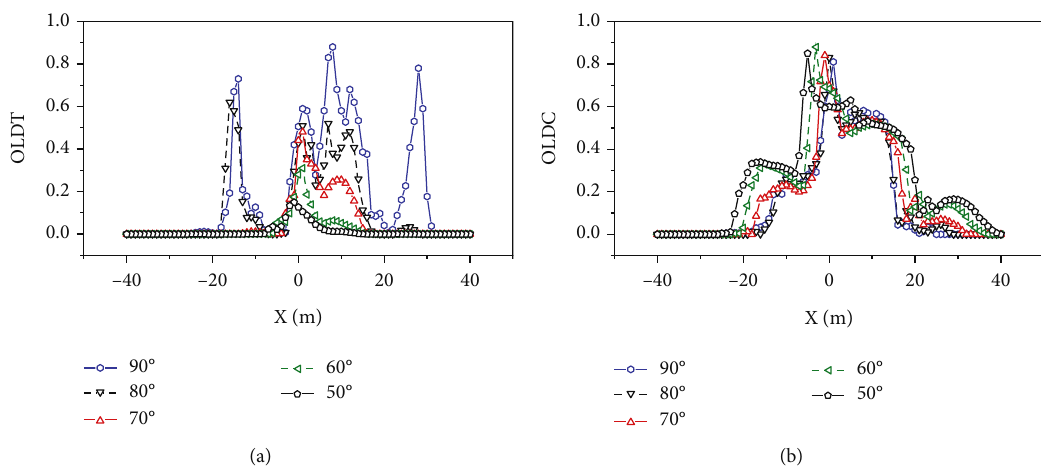
Figure 13: Overall lining damage under di ff erent tunnel-fault intersection angles. (a) OLDT. (b)